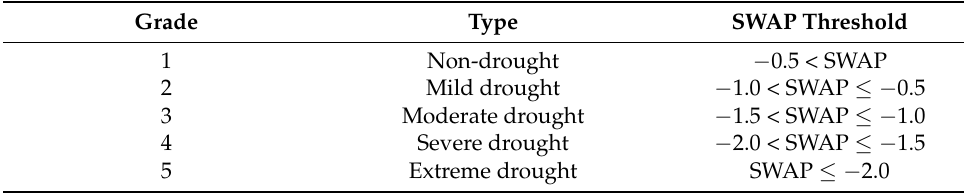
Table 1. Classifications of SWAP drought